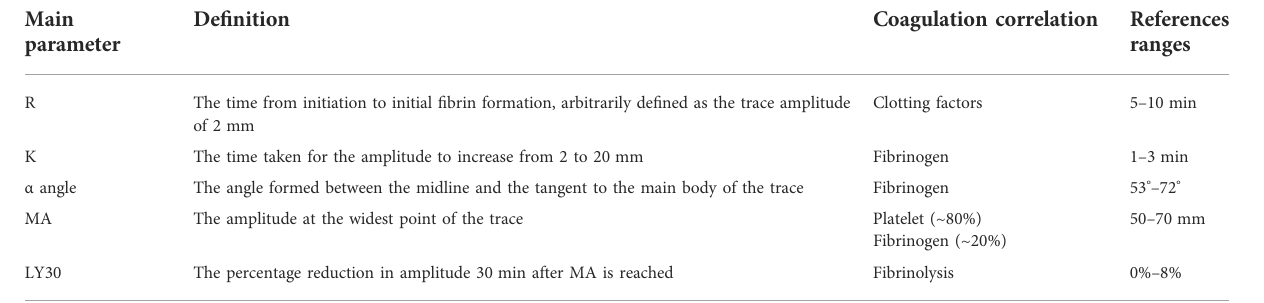
TABLE 5 Interpretation of TEG-5000